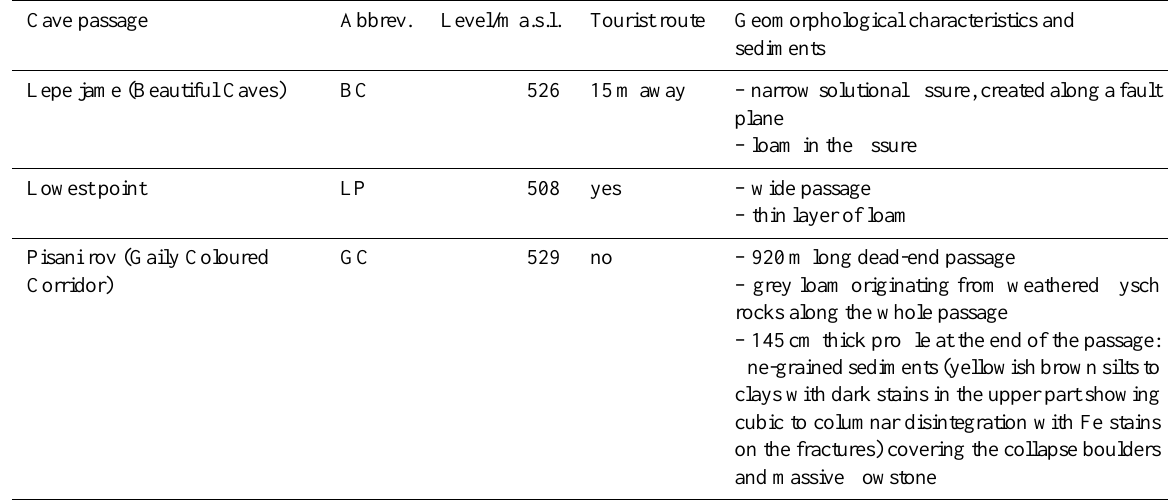
Table 1. Geomorphological characteristics of cave passages with measurement locations. Cave passage Abbrev.